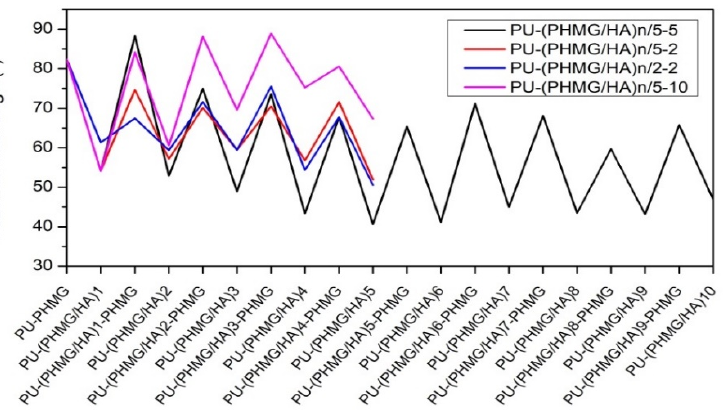
Figure 3. Water contact angle (WCA) of modified PU films. n in PU-(PHMG/HA) n /5-5, PU-(PHMG/HA) n /5-2, PU-(PHMG/HA) n /2-5 and PU-(PHMG/HA) n /5-10 was the number of bi- layer.